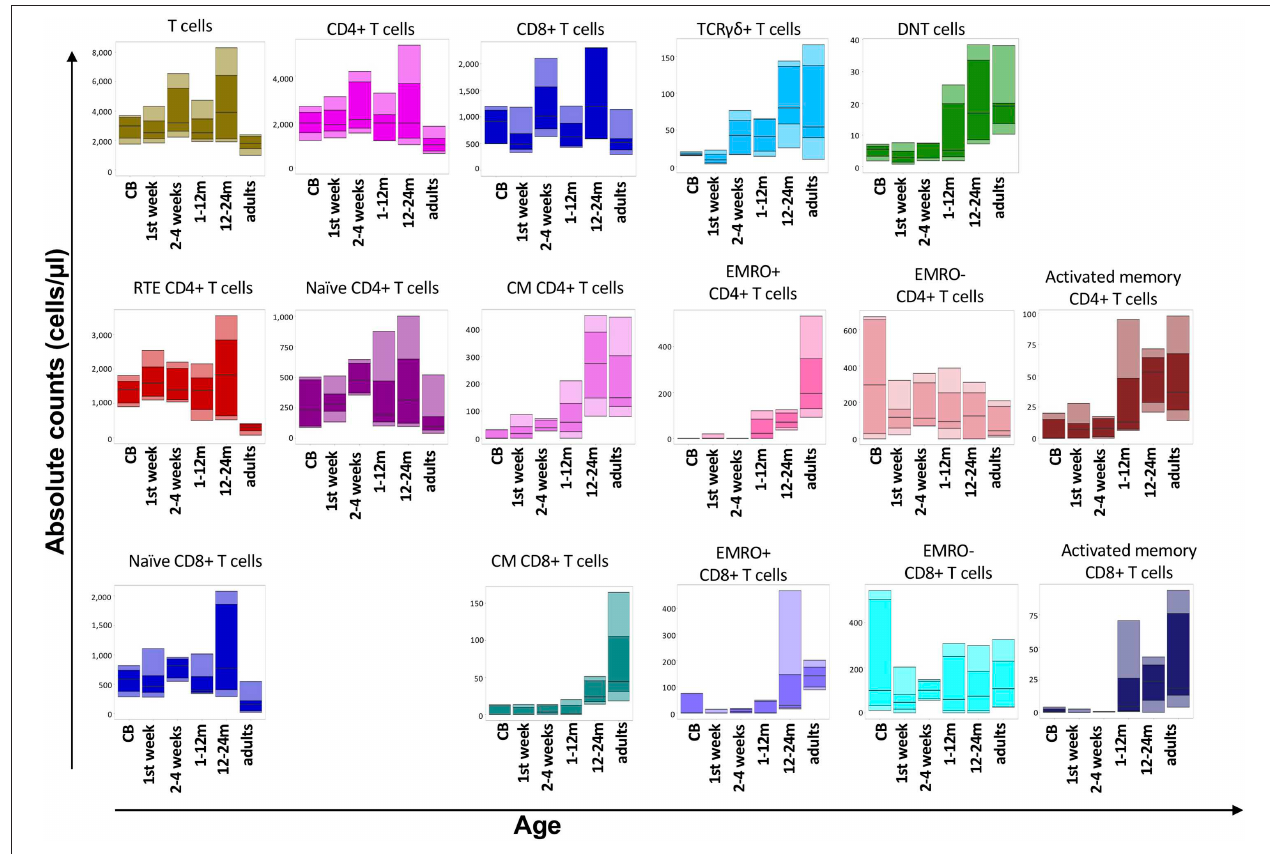
FIGURE 3 | Flow cytometric analysis of T-cell populations using the EuroFlow SCID/RTE tube in 56 healthy controls of five different age ranges. All values of this reference data set are displayed as bar graphs representing the median, and p10, p25, p75, and p90 percentiles. For data visualization package gplot2 for the statistical language R was